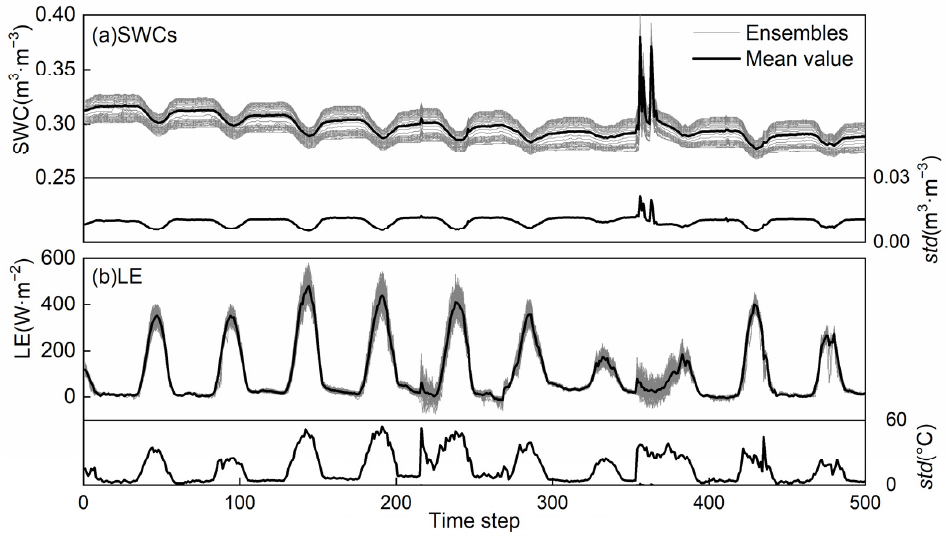
Figure 11. Ensemble perturbation and its std .